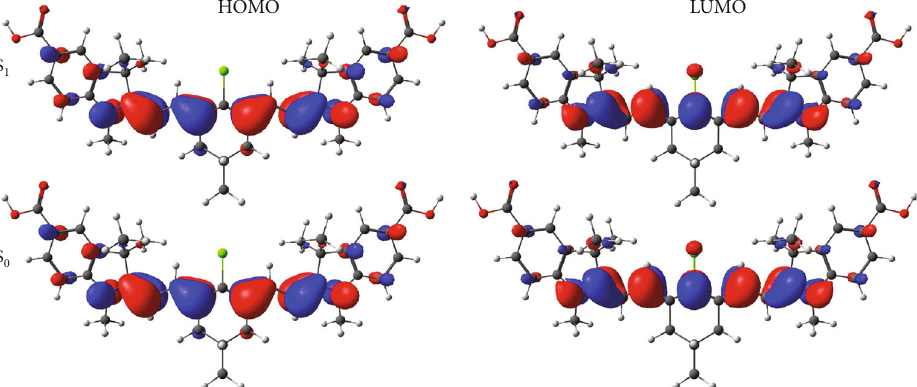
⟶ S ⟶ S and S involving the ground and fi rst excited states of cyanine 0 1 1 0